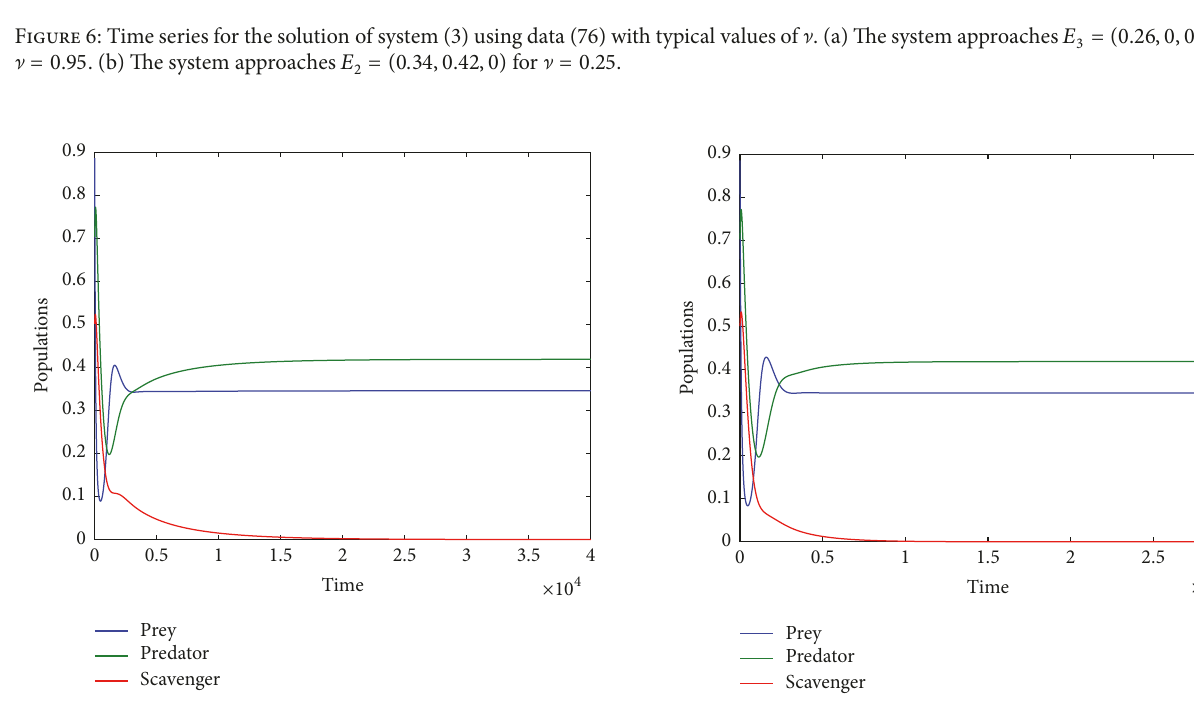
Figure 7: Time series for the solution of system (3) using data (76) with 𝜔 = 0.02 . The system approaches 𝐸 2 = (0.34,0.42,0) .